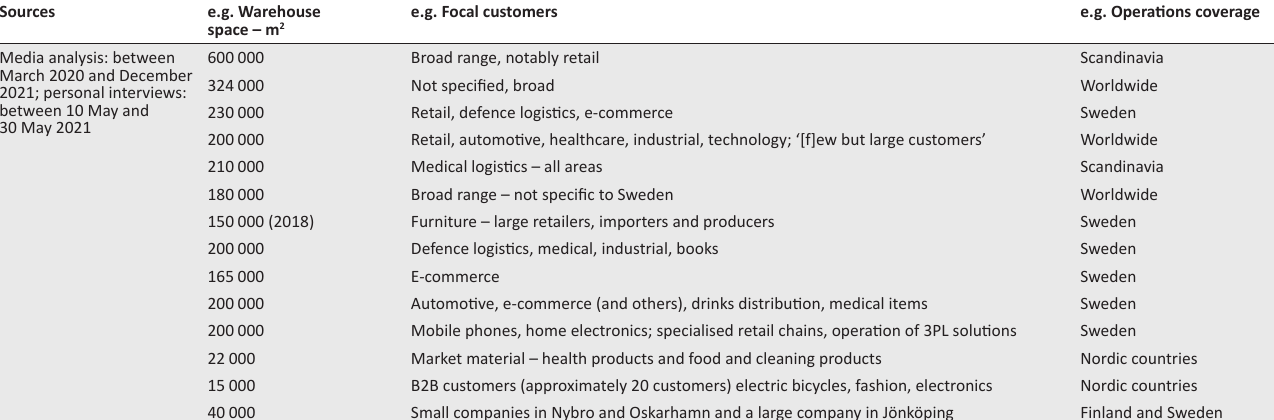
TABLE 2: Excerpt from research database with data from interviews, Retriever Business and Mediearkivet .